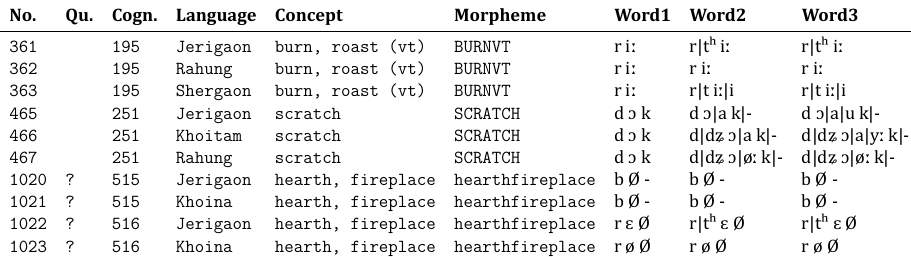
Table 4: Example output format of our automated reflex retrodiction